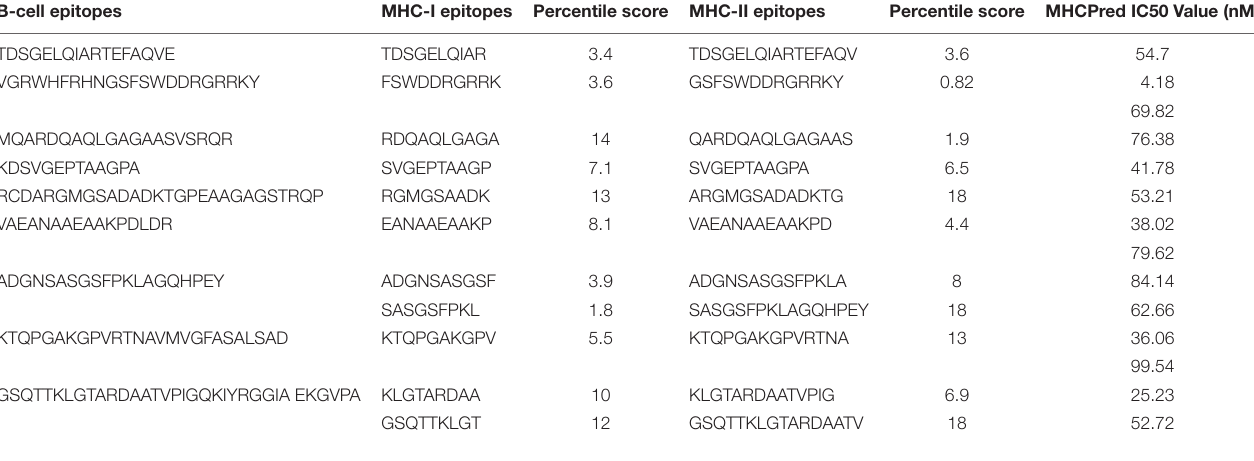
TABLE 5 | T cell epitopes predicted from B